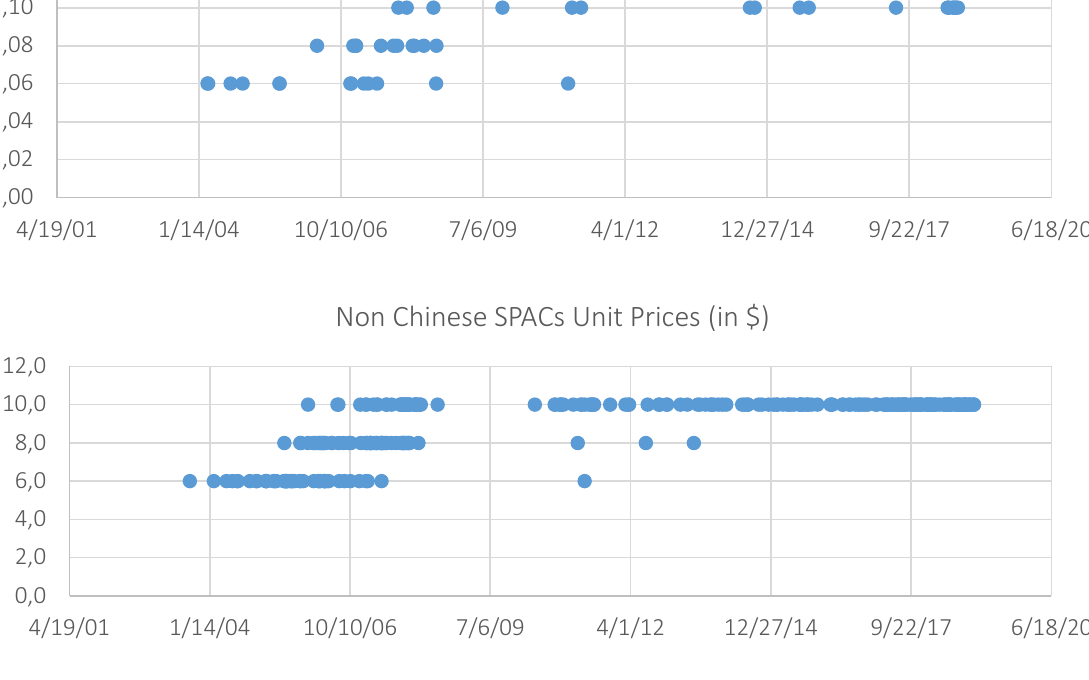
Figure 1. Unit offer